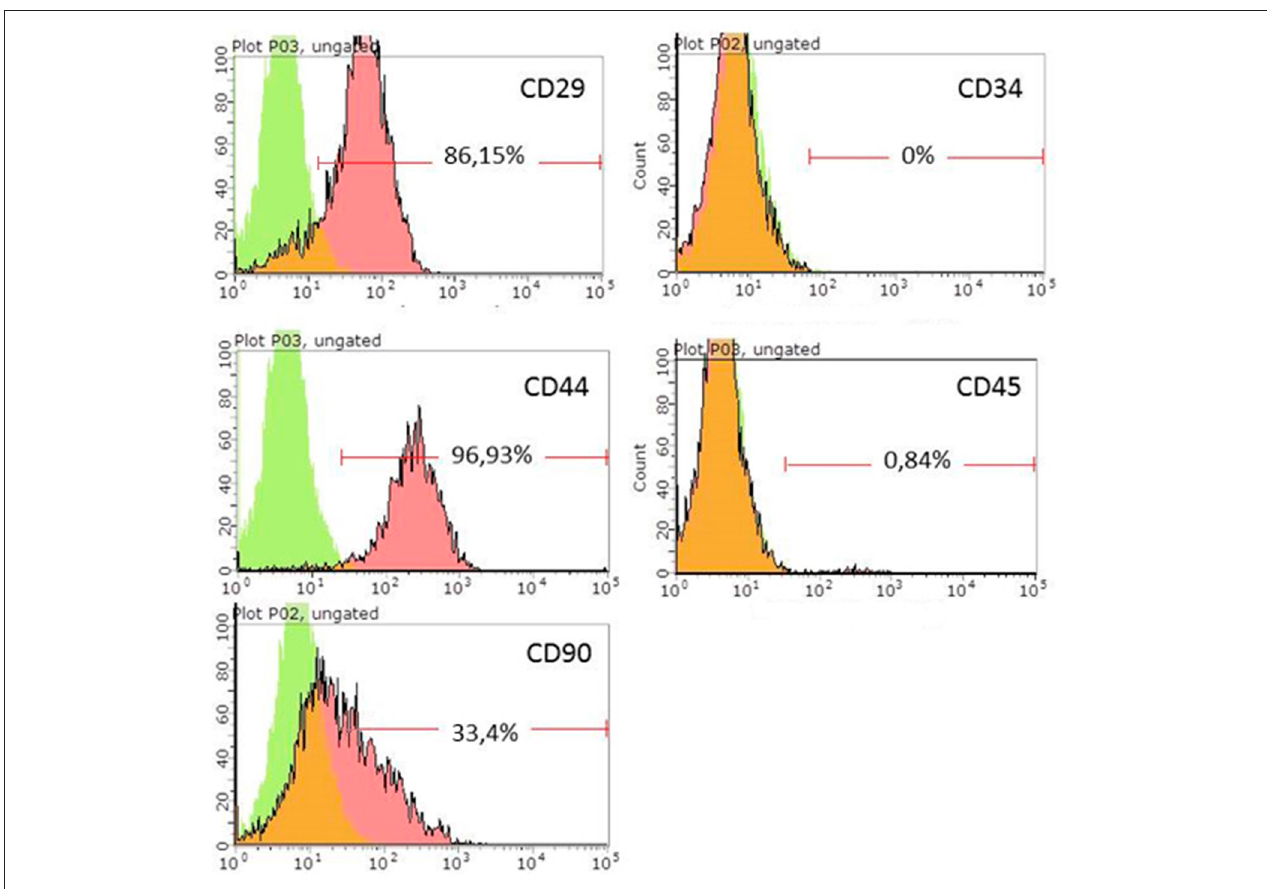
FIGURE 1 | Flow cytometry analysis of rat ADSCs. Green, isotype control; Red, stained cells.